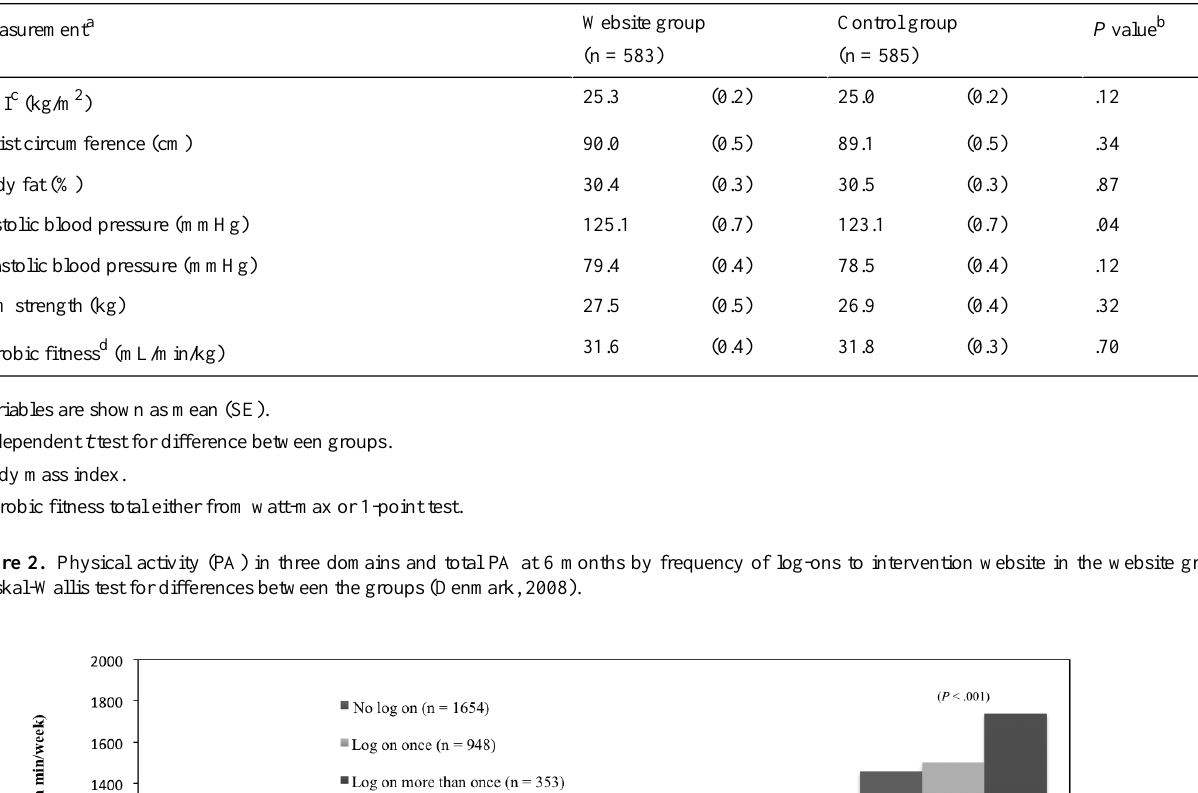
Table 5. Health examination measurements of the subsample of participants at 3-month follow-up by website and control group (intention-to-treat analysis) (Denmark, 2008).